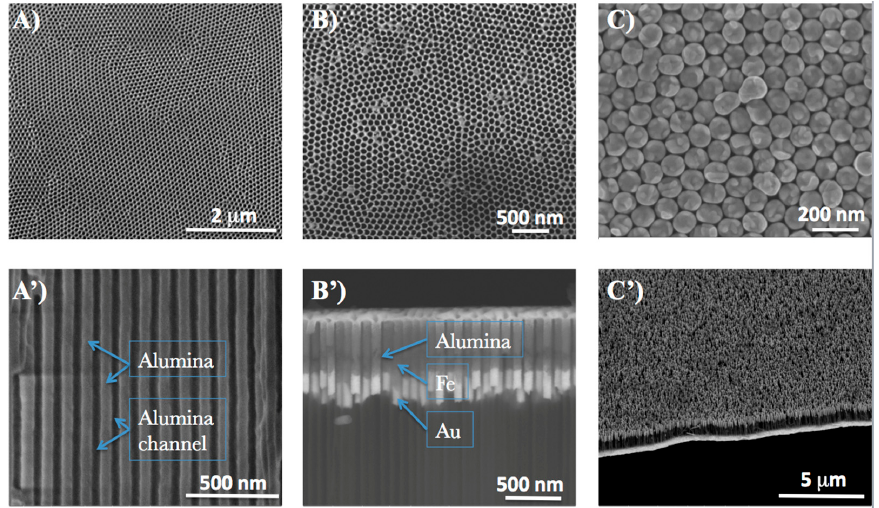
Figure 2. SEM images of different samples at different fabrication steps: ( A , A’ ) APA template fabricated from the aluminum disc; ( B , B’ ) after electrodeposition of metals in the APA channels with Fe and Au in the column; ( C , C’ ) the forest-type Au (400 nm)/Fe nanowires after wet-etching of alumina.